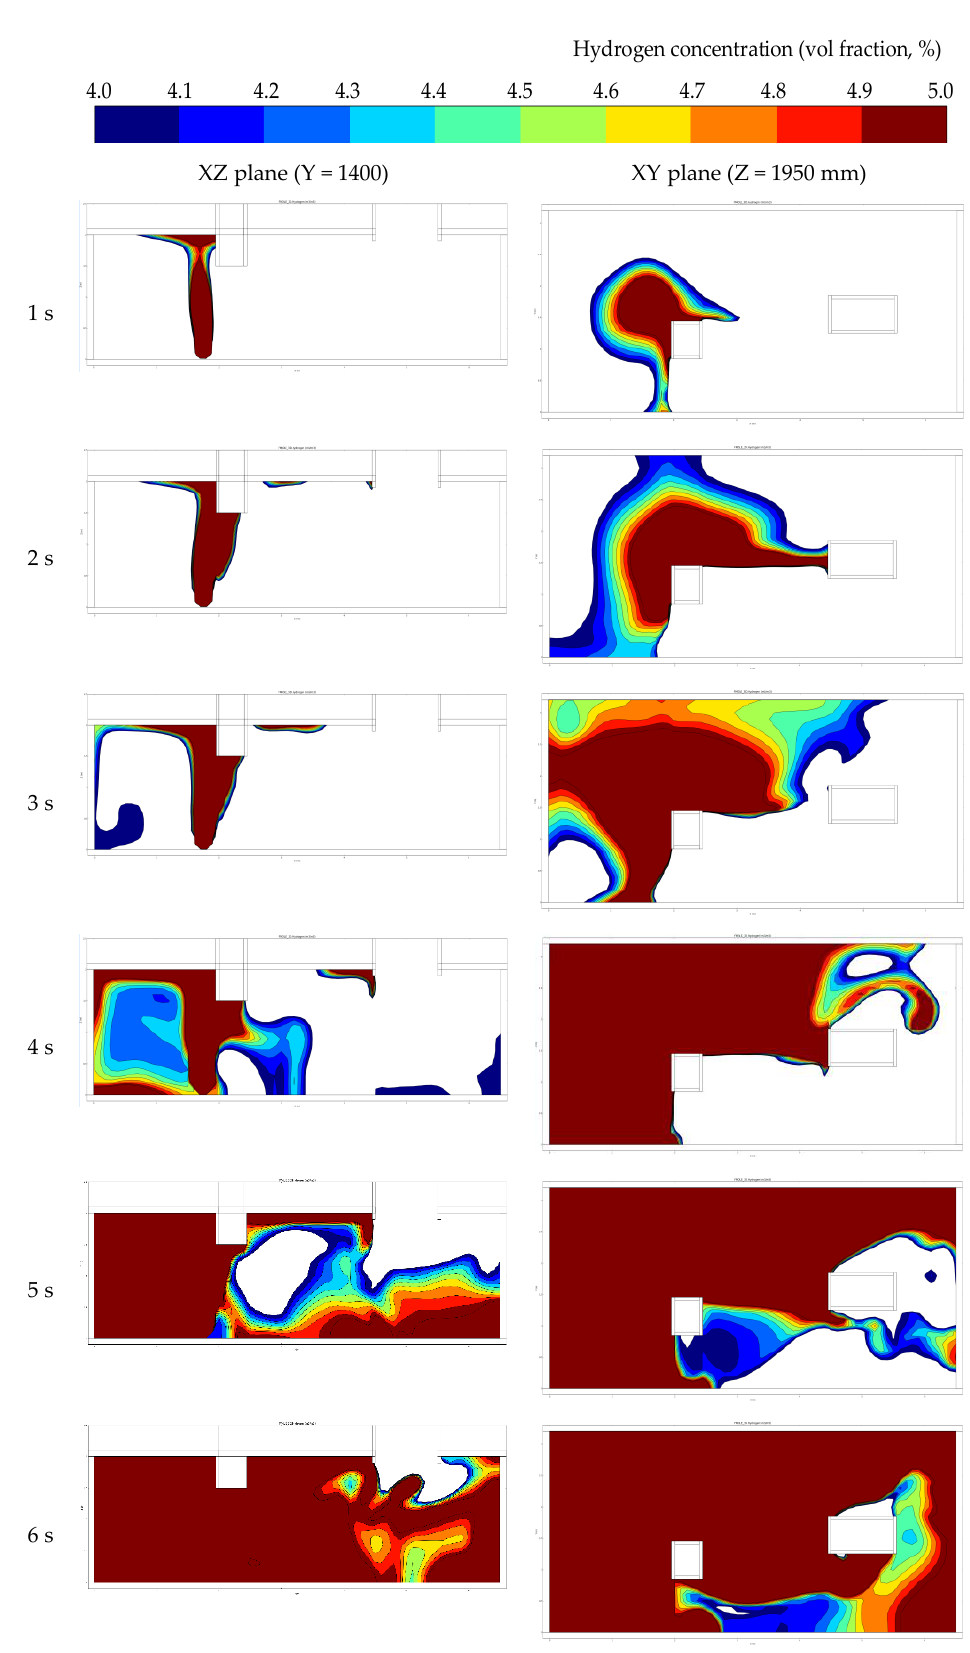
Figure 9. Two-dimensional slice views of hydrogen gas dispersion in the fuel cell room (on the XZ and XY plane) at different times from 1 s to 6 s (the times represent the seconds after the start of hydrogen